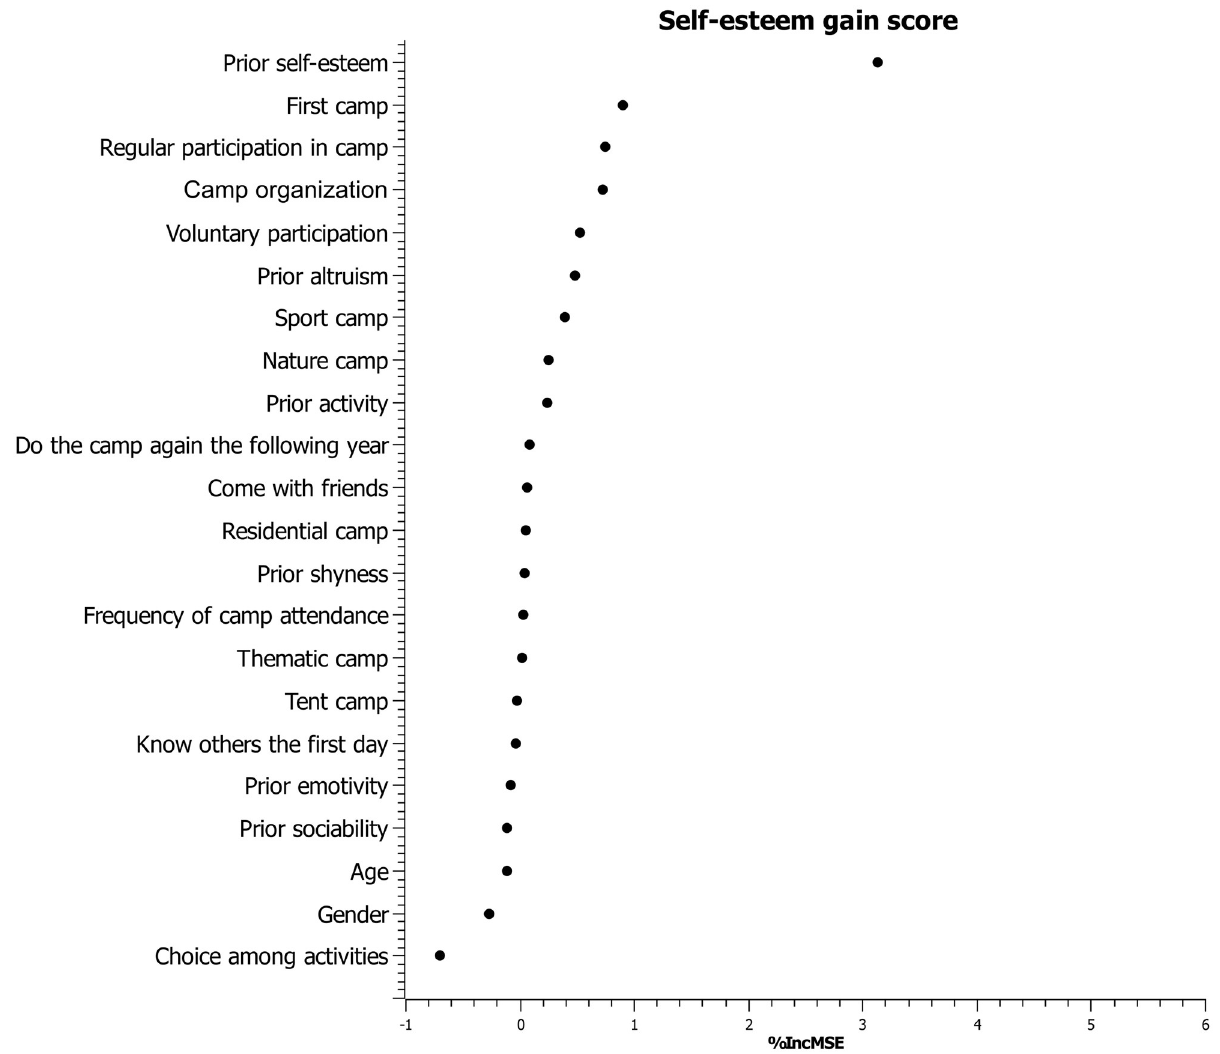
Fig 3. Variables importance plot for self-esteem gain score in the camp